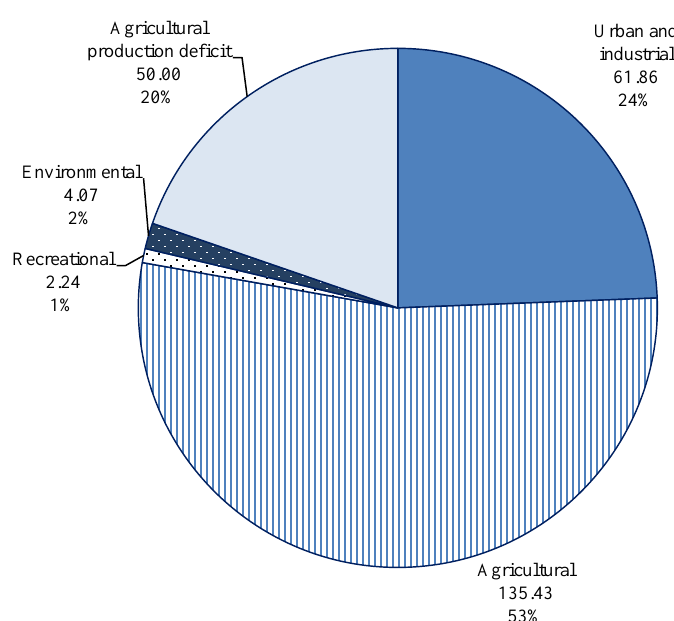
Figure 8. Water demands in the study area, shown in hm³/year and percentage. Source: own elaboration relying on previous sections.